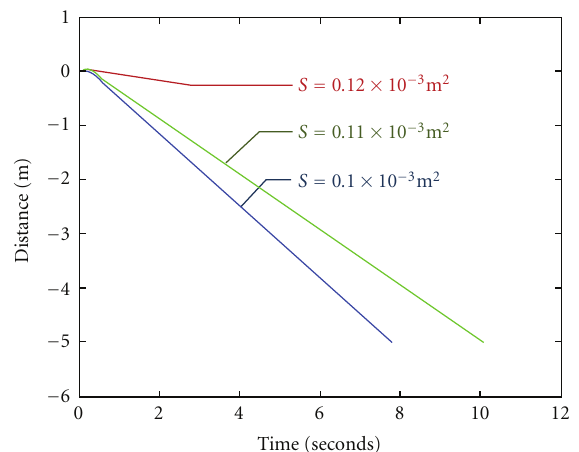
Figure 14: Dragonfly flapping straight—changing the wing area. Velocity versus time.